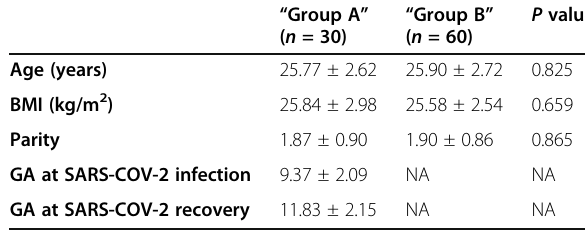
Table 1 Demographic characteristics of pregnant women in both